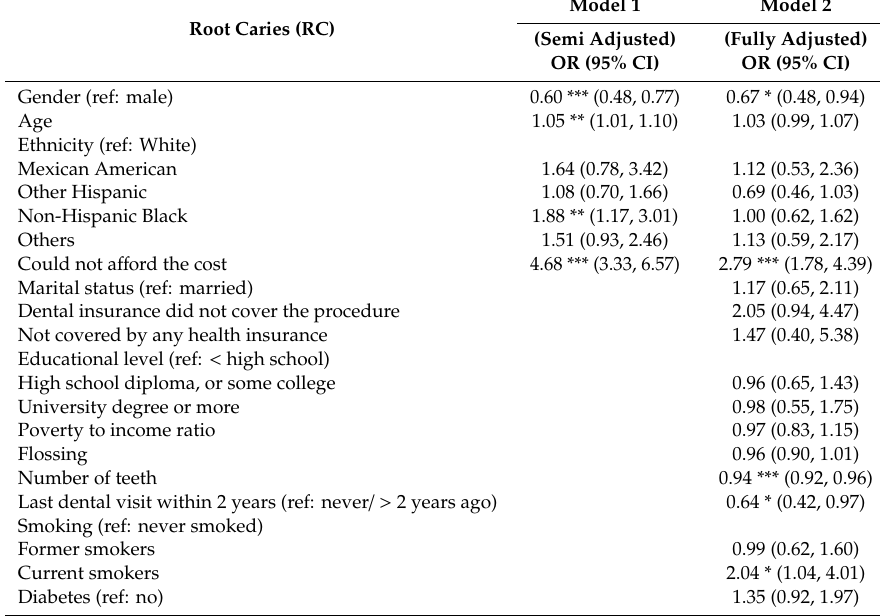
Table 2. Logistic regression odds ratios for factors associated with untreated root caries in older Americans aged 65 + , NHANES 2015–2018, ( n =